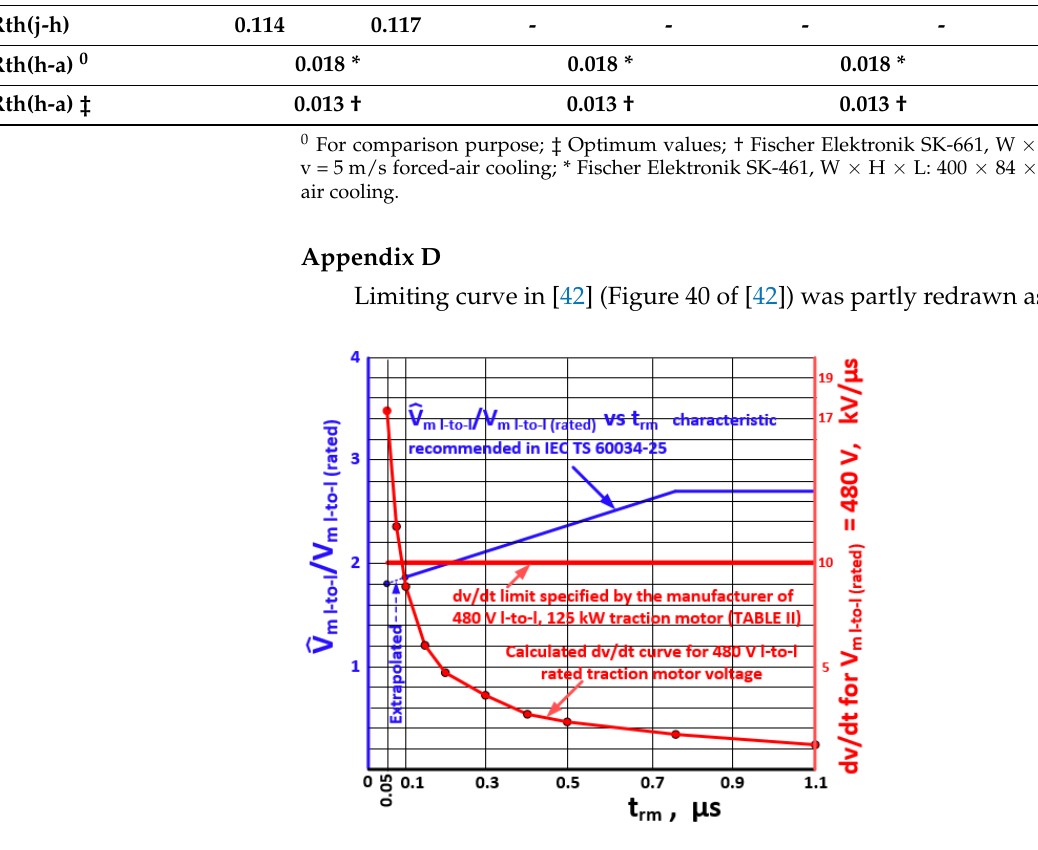
Figure A2. Permissible operating ranges of vehicle current against catenary line voltage.